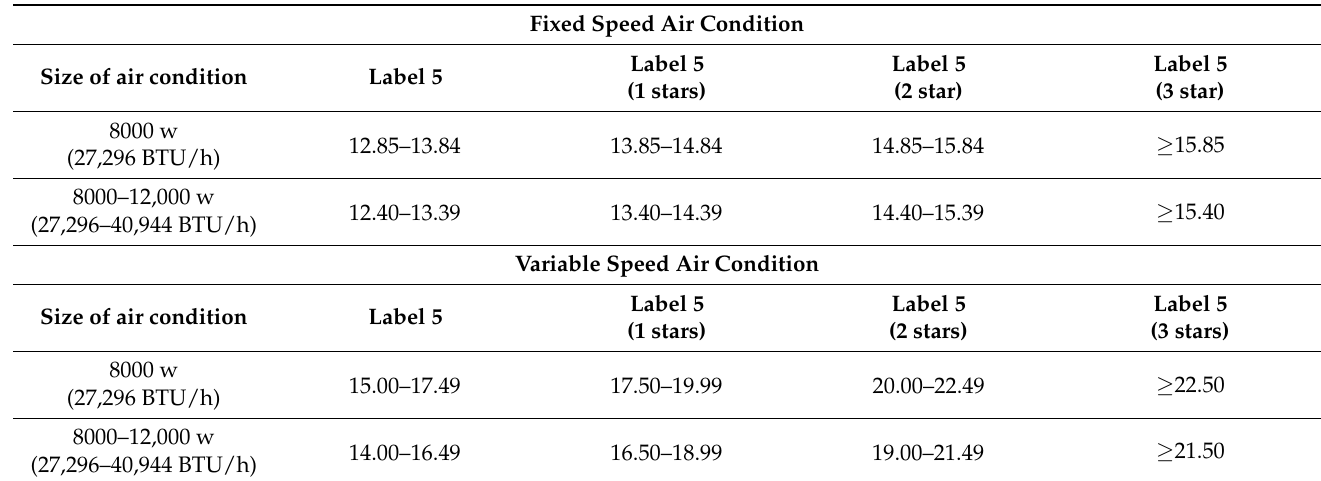
Table 4. Allowance SEER (seasonal energy efficiency ratio) value for split type air conditioning